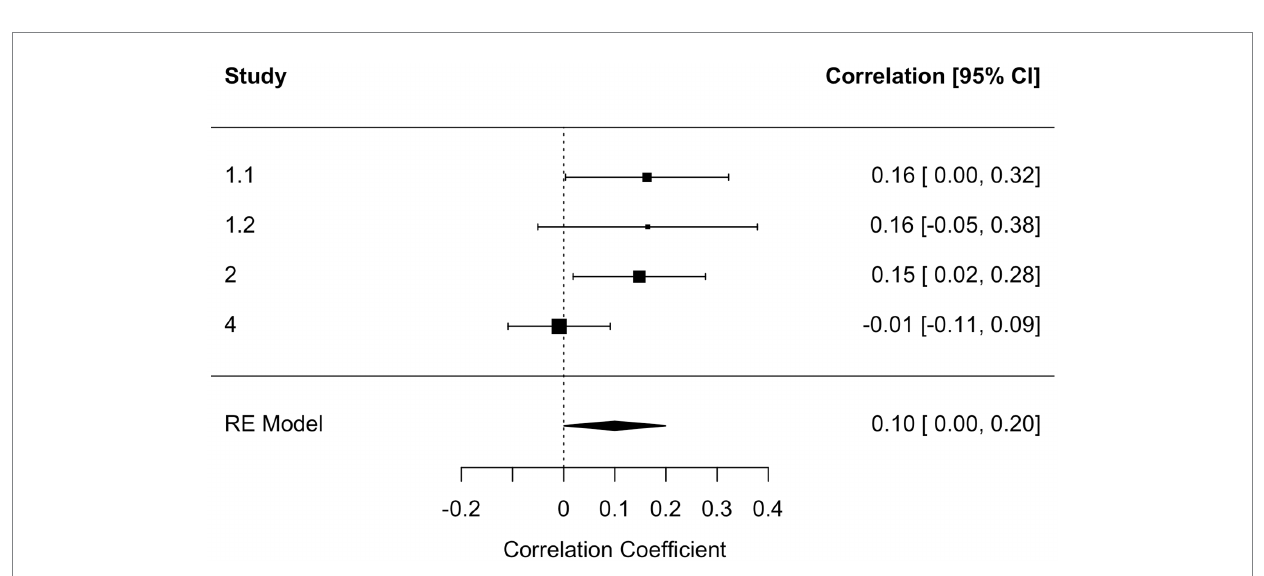
FIGURE 3 Forest plot of random effects meta-analysis between reading time (log) and kama muta across Studies 1 and 2. Q (3) = 5.72, p = 0.126, I 2 = 48.29 [0, 94.75]. Note that the lower confidence interval is